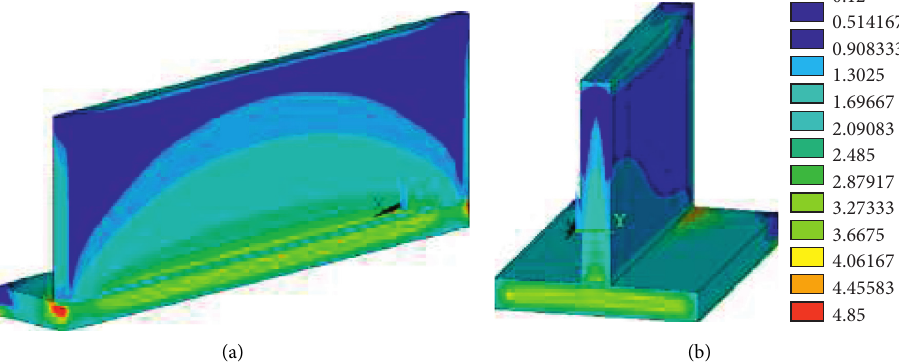
Figure 6: Stress envelope diagram of sluice model for IC along and vertical to flow direction